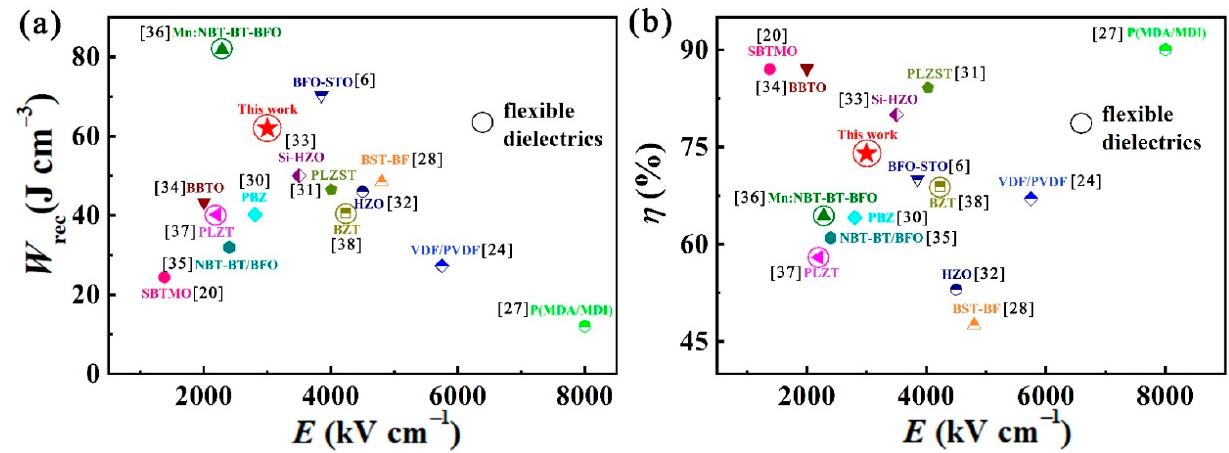
Figure 6. A comparison of the ( a ) W rec and ( b ) η of the flexible BST/0.4BFO-0.6STO film capacitor reported in this study and a number of film capacitors reported